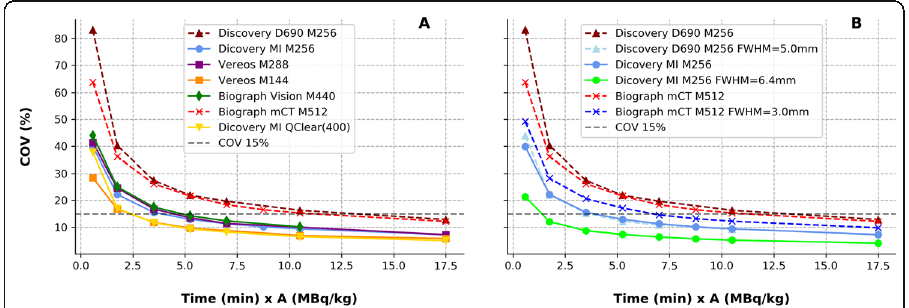
Fig. 3 COV as a function of the time-activity-product (TAP) for all tested clinical setups. Iterative reconstruction setups without Gaussian smoothing ( a ) and comparison of Gaussian vs. non-Gaussian setups for devices that used the Gaussian smoothing in the clinic ( b ). Digital devices were labeled with full lines and dashed lines represent the obtained results with analogue